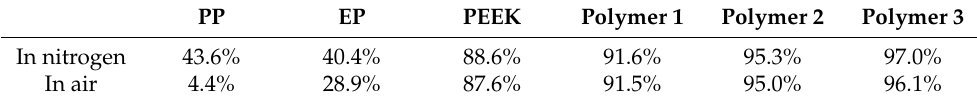
Figure 18. Long-term stability of five materials in an air atmosphere at 300 °C. Table 5. Long-term stability data for several polymers in inert and air atmospheres. PP PEEK Polymer